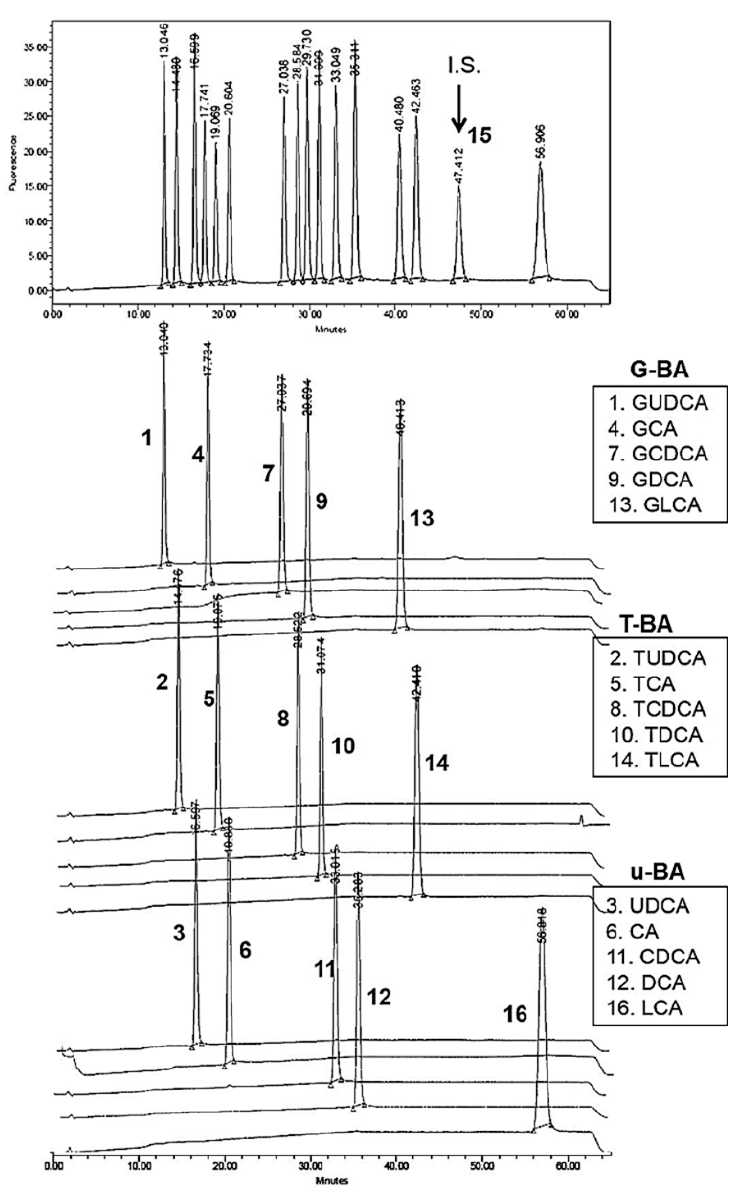
Figure 2. HPLC chromatogram of bile acid standard solution with 5 β -Pregnane-3 α , 17 α , 20 α -triol (IS) in methanol. Bile acid standards include 15 types of bile acids such as glycine-conjugated bile acids (G-BA: #1, #4, #7, #9, #13), taurine-conjugated bile acids (T-BA: #2, #5, #8, #10, #14), and unconjugated bile acids (u-BA: #3, #6, #11, #12, #16). Below the chromatogram of standard mixtures and IS compound (#15), each chromatogram obtained from the HPLC analysis separately performed with each bile acid compound was displayed with the specific retention time (min).